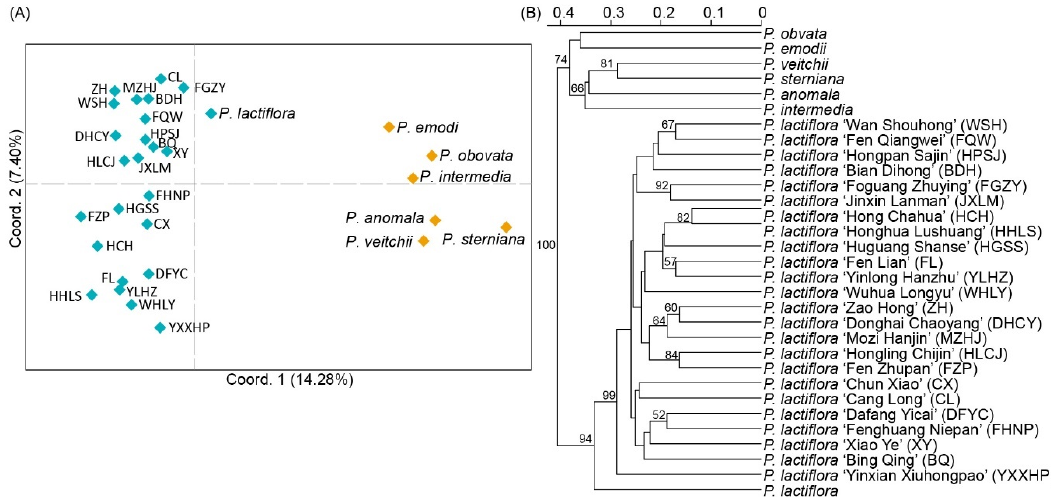
Figure 4. Principal coordinates analysis (PCoA) of amplified loci ( A ) and dendrogram generated by Bruvo’s distances ( B ) of 31 accessions, including seven species and 24 cultivars of Paeonia lactiflora . The cultivar names are abbreviated with capitalized letters in ( A ), and their full names are shown in ( B ). The UPGMA tree was produced with 1000 bootstrap replicates, and the node values greater than 50 are shown in the